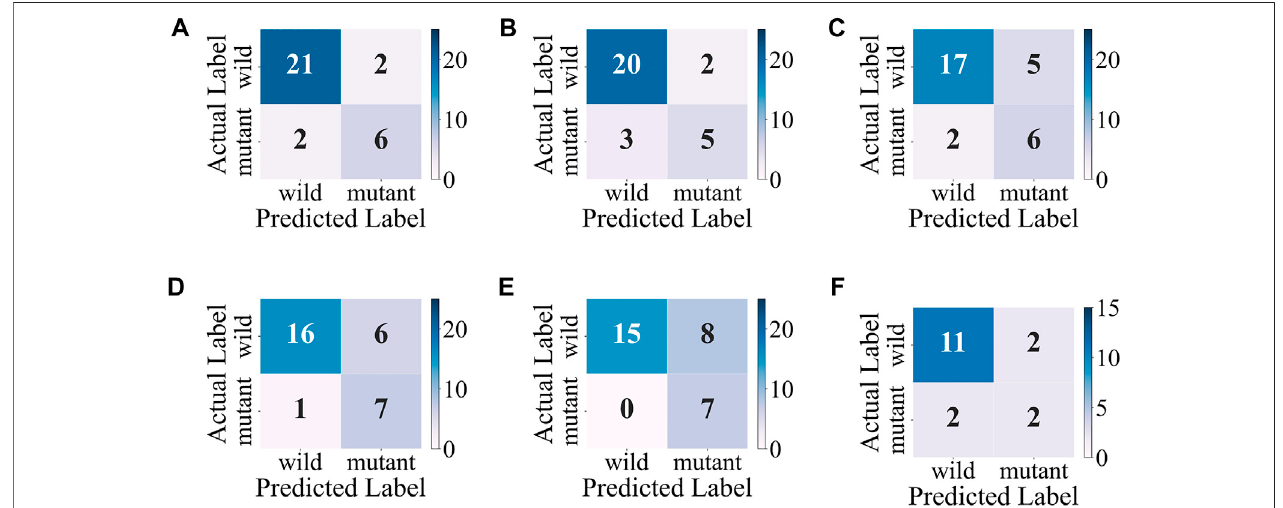
FIGURE6| Confusionmatrixes oftheSVM. (A – E) Confusionmatrixesonthevalidationsets duringthe5-fold cross-validation. (F) Confusionmatrixonthetestset.